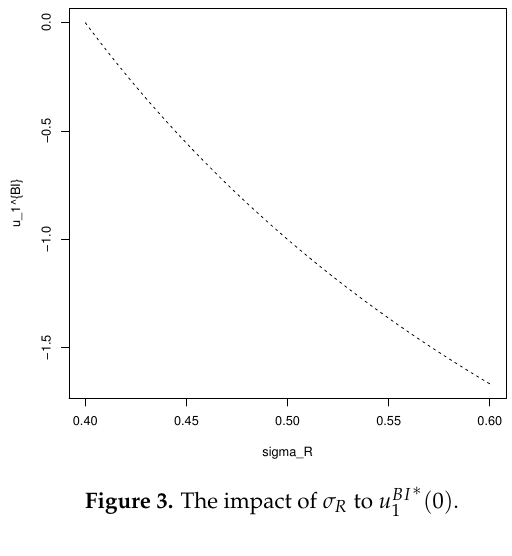
Figure 3. The impact of σ R to u BI